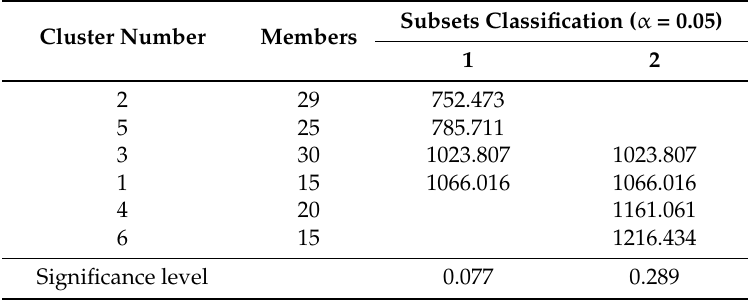
Table 3. Duncan’s pairwise comparison